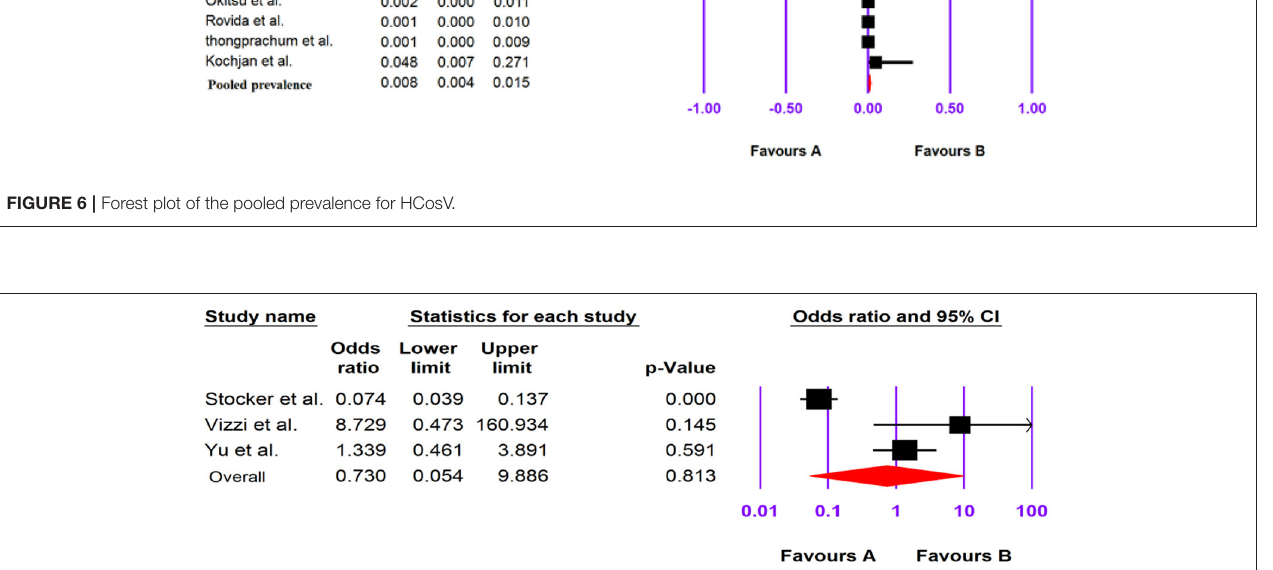
Frontiers in Medicine |